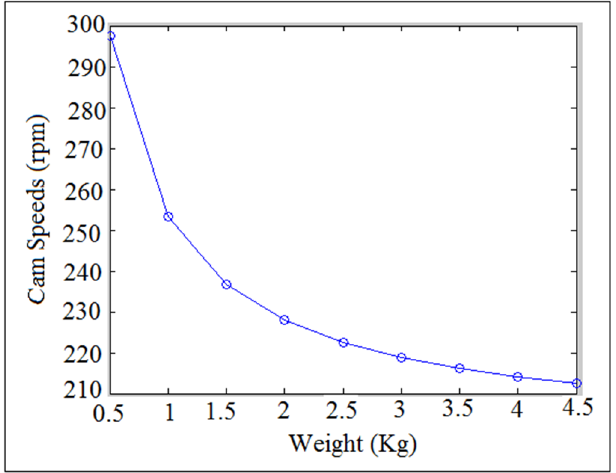
Figure 3. Cam speed against weight.